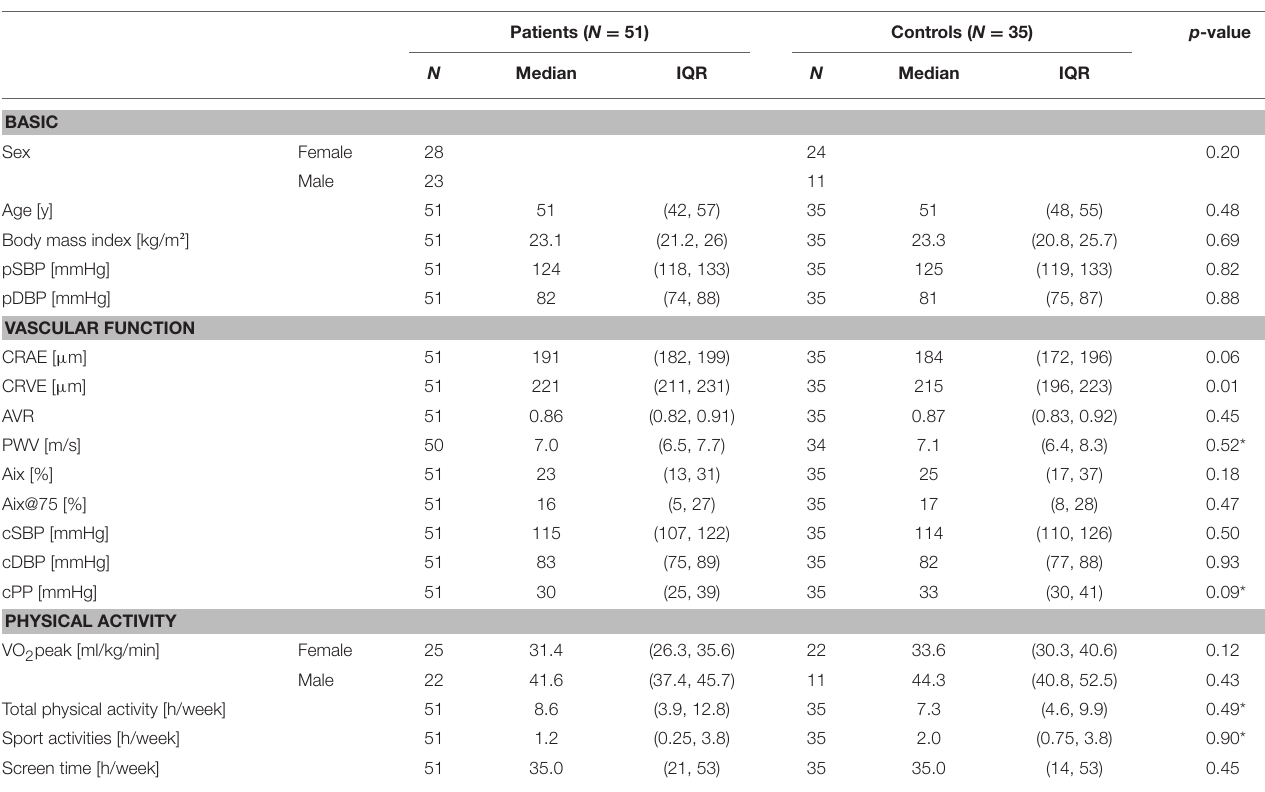
TABLE 1 | Participant